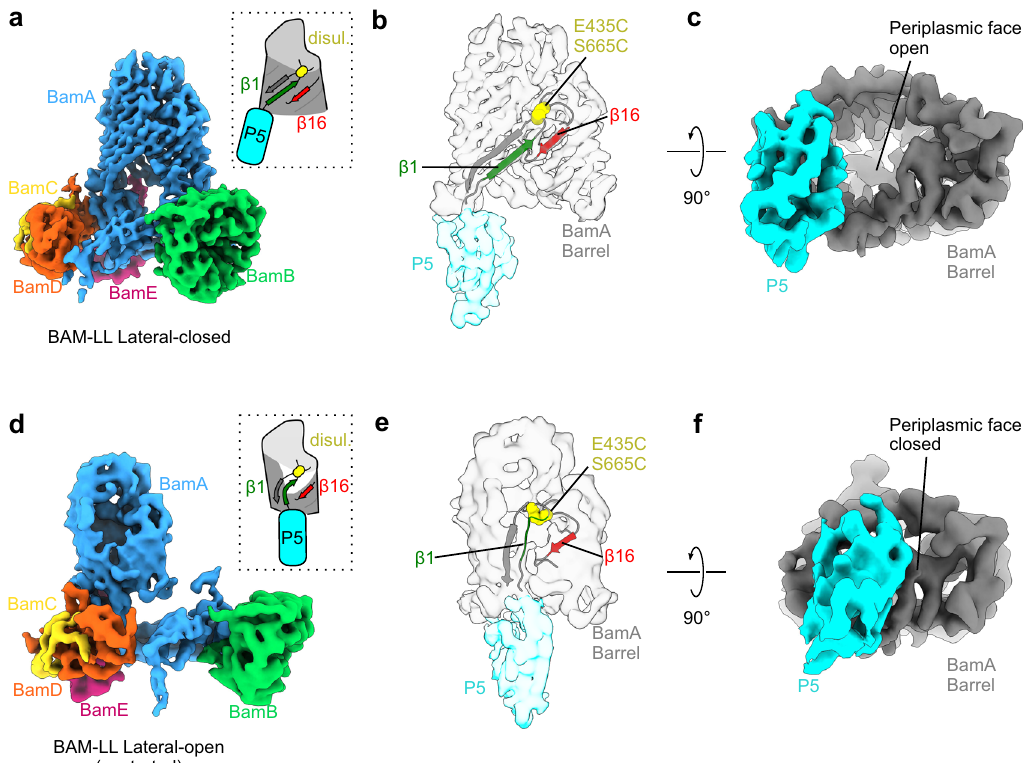
Fig. 2 CryoEM resolves two conformations of BAM-LL in detergent. a 4.1 Å cryoEM map of the BAM-LL lateral-closed conformation at a contour of 10 σ , coloured by subunit. The lateral gate is closed and POTRA-5 does not block the BamA barrel ( schematic inset ). b Cartoon representation of the corresponding atomic model at the lateral gate, superimposed on the segmented density for the barrel and POTRA-5 of BamA. β 1 and β 16 contact to close the gate. c The same density viewed from the periplasmic side, showing the open lumen of the BamA barrel in this conformation. d 4.8 Å cryoEM map of the BAM-LL lateral-open (contorted) conformation at a contour of 10 σ , coloured by subunit. The lateral gate is open and POTRA-5 occludes the BamA barrel ( schematic inset ). e Cartoon representation of the corresponding atomic model at the lateral gate, superimposed on segmented density for the barrel and POTRA-5 of BamA. To satisfy the disulphide in this conformation, eL1 must bend back into the barrel to contact eL6. f The same density viewed from the periplasmic side, showing that the BamA lumen is blocked by POTRA-5 in this conformation. Figure made in UCSF ChimeraX 76 . Segmenting and colouring performed with corresponding atomic models. Less well-resolved regions and the micelle have been